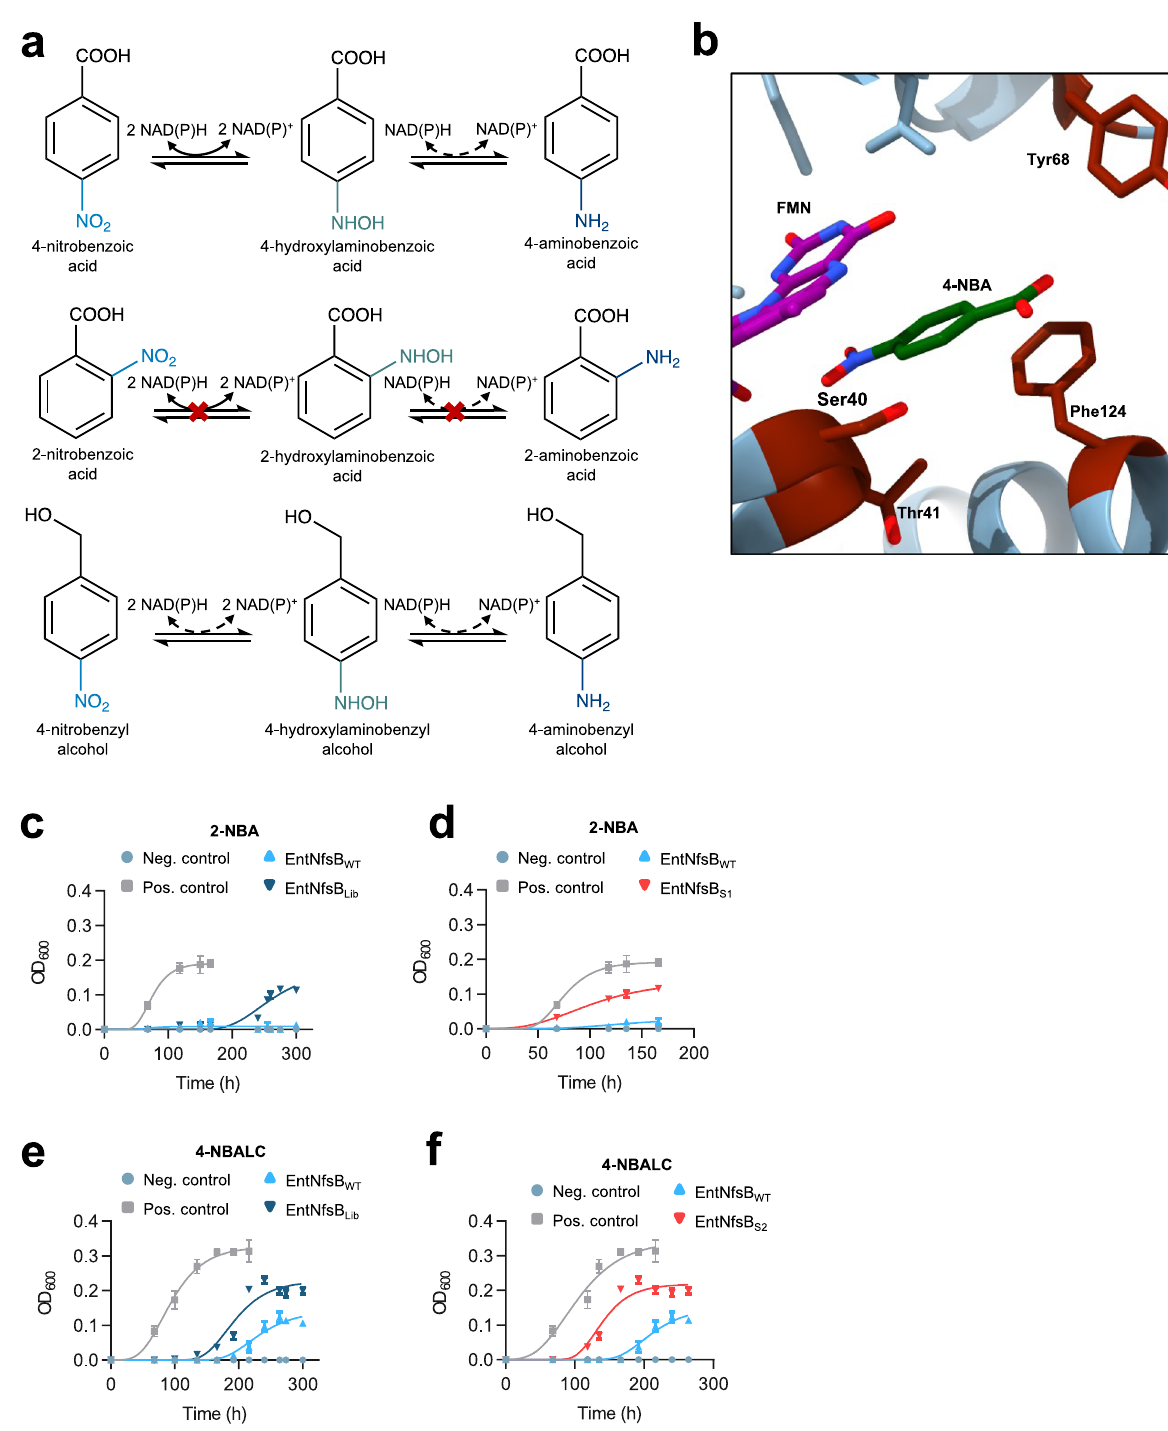
Fig. 5 Chemically-directed selection of nitroreductase variants with altered substrate speci fi city. a Catalytic activities of EntNfsB ( Enterobacter cloacae nitroreductase NfsB). EntNfsB is able to reduce several nitroaromatic compounds, such as 4-nitrobenzoic acid (4-NBA), using NADH or NADPH as cofactors. EntNfsB WT is also able to reduce 4-nitrobenzyl alcohol (4-NBALC) less ef fi ciently, but does not display any activity towards 2-nitrobenzoic acid (2-NBA). b Substrate binding site of EntNfsB WT with 4-NBA bound (PDB code 5J8G). Residues 40, 41, 68, and 124 were close to the substrate, and did not contact the FMN group essential for catalysis. Anaerobic culture of AL cells transformed with the library EntNfsB Lib (pLS169) in M9 glucose medium with 2-NBA ( c ) or 4-NBALC ( e ). Controls are as in Fig. 1. d Anaerobic culture of AL cells transformed with EntNfsB S1 (with substitutions S40A, T41I, and F124A; pLS169_1), the variant with activity towards 2-NBA, in M9 glucose medium supplemented with 2-NBA. f Anaerobic culture of AL cells transformed with EntNfsB S2 (with substitutions T41L, Y68L, and F124L; pLS169_3), the variant with improved activity towards 4-NBALC, in M9 glucose medium supplemented with 4-NBALC. Data points of growth curves represent mean values, with error bars showing standard deviation; n = 3 biologically independent cultures for all timepoints of growth curves. Source data are provided as a Source Data fi le.